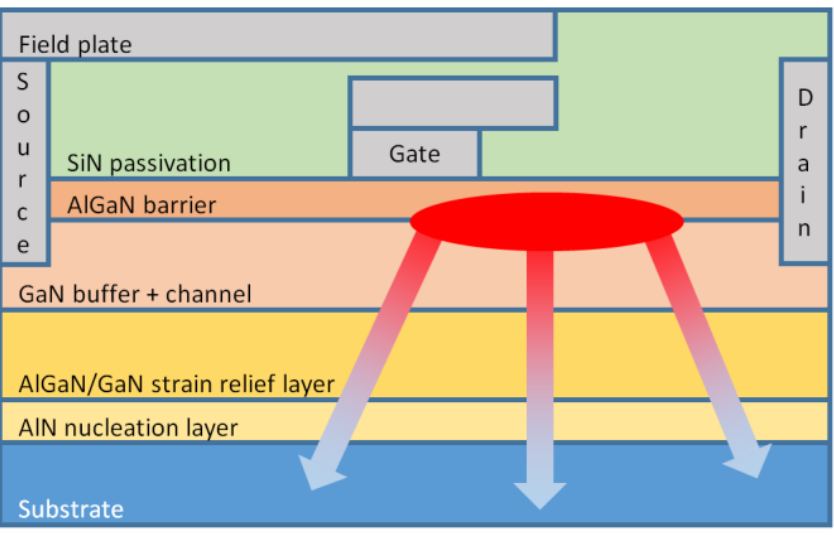
Figure 1. Simplified representation of an AlGaN/ GaN HEMT structure; drawing not to scale. Table 2. Typical thermal conductivity of the materials present in an AlGaN/GaN HEMT [1,7,9 – 11,46 – 48].